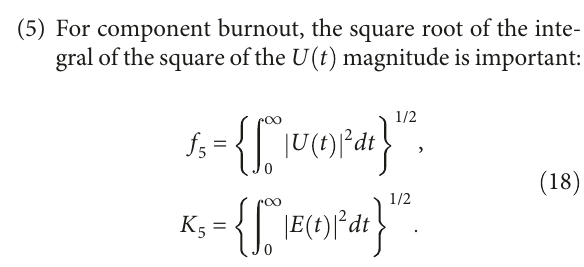
are sorted out in an ascending order, and based on the